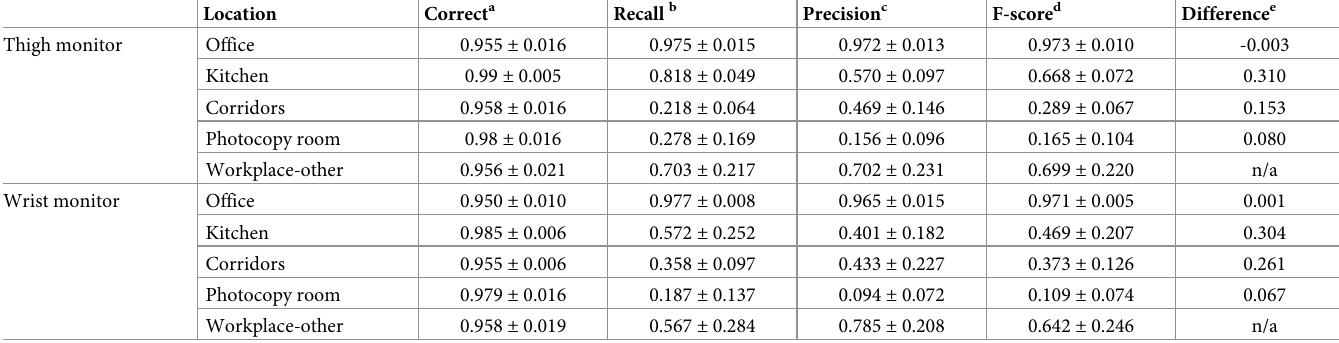
Table 3. Agreement between the monitor determined location and direct observation when measuring multiple locations, using the decision model (Mean ± SD across the 5 holdout samples of n = 6 participants).